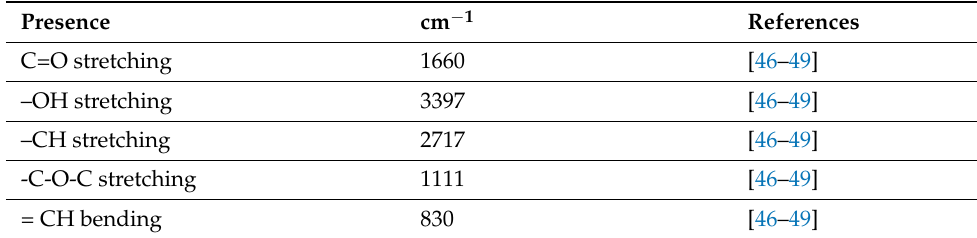
Table 2. FTIR frequency ranges and functional groups present in